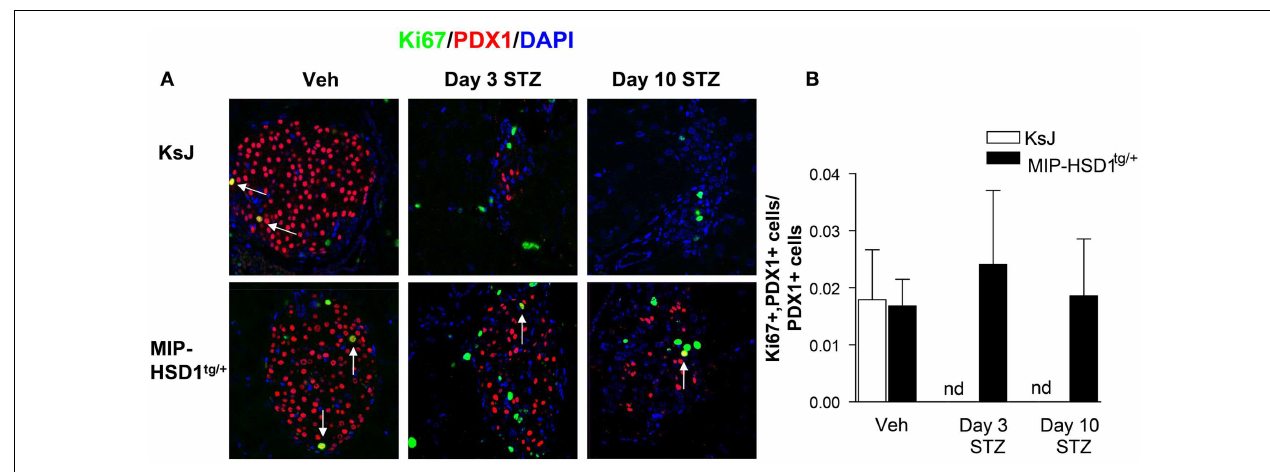
and Ki67 positive cells were counted within the islets as defined morphologically by the islet capsule boundary using Image J software. Proliferating β -cells were measured as a ratio of PDX1, Ki67 double-positive cells over total PDX1-positive cells. Ki67 and PDX1 double-positive staining was undetectable (nd) in KsJ mice 3 and 10days post-STZ treatment.Values represented mean ± SEM, differences were analyzed by one-way ANOVA, Newman–Keuls test ( n = 6–12).